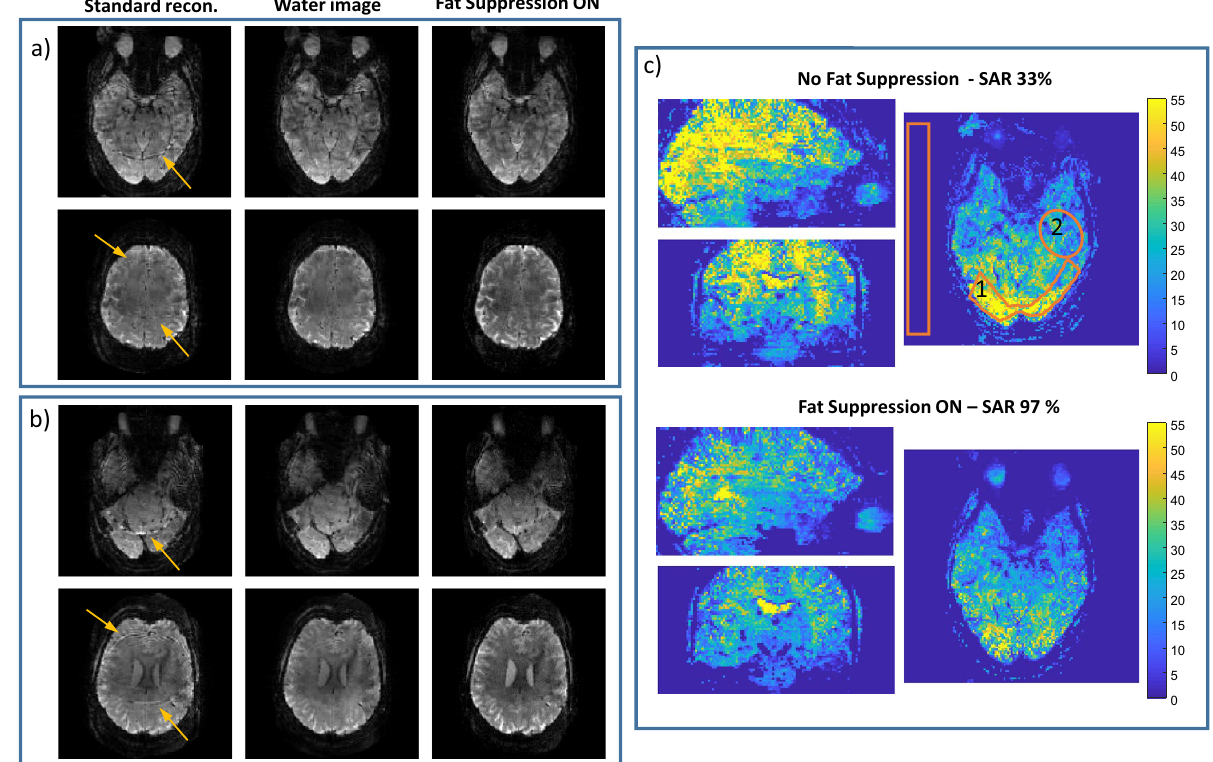
Figure 6. Human imaging—resting-state fMRI scan. Reconstruction of two pairs ( a and b ) of simultaneously acquired slices; comparing, left to right, standard reconstruction, a water image after lipid separation and an image acquired with fat suppression. ( c ) tSNR comparison in three orthogonal planes. Yellow arrows in ( a ) and ( b ) point to the artifact due to the lipid signal in the standard reconstruction. The orange overlays in ( c ) show regions (1) and (2) for the SNR and tSNR estimation. The SAR was 33% (without fat-suppression) and 97% (with fat-suppression) where the reference amplitude for 1 ms 180° hard pulse was 240